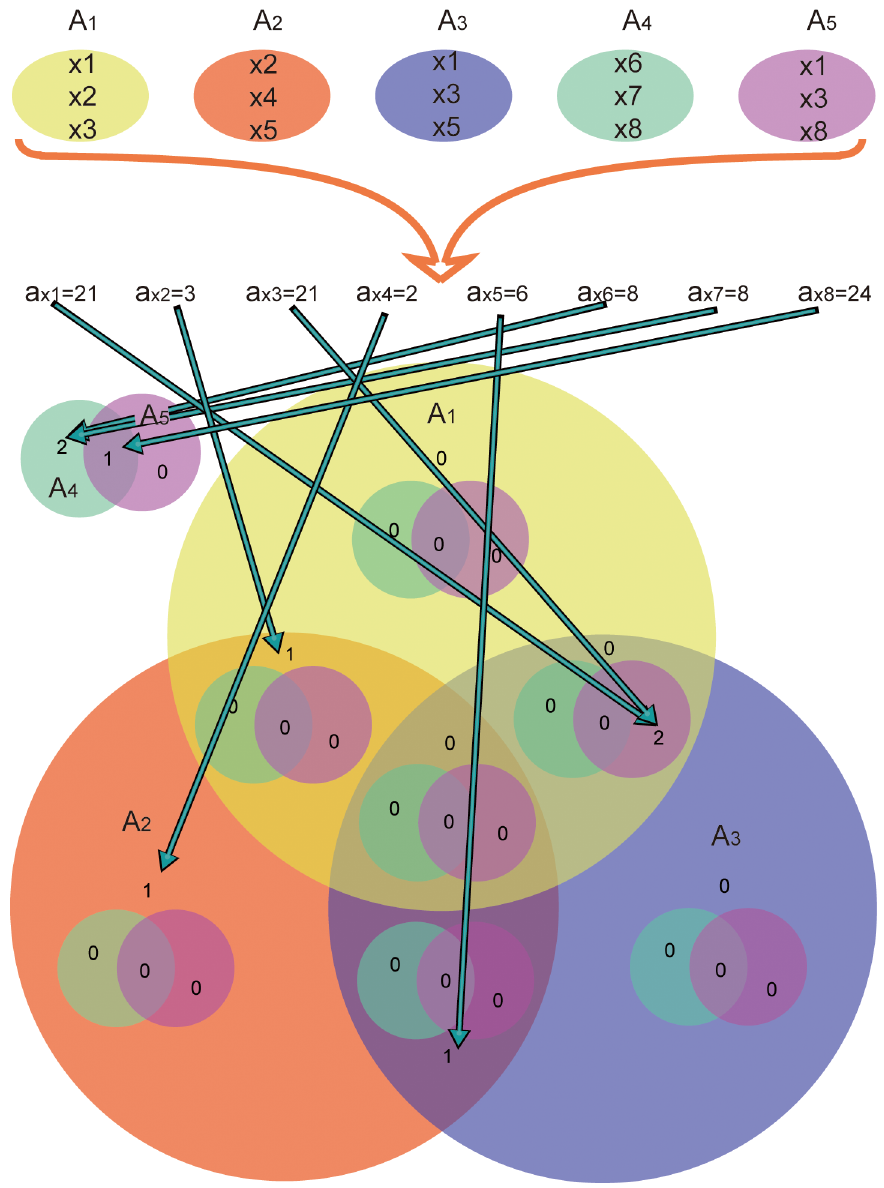
Fig 3. Work flow of VennPainter. The workflow has three steps: 1, calculate all label elements; 2, find the corresponding label in the Venn diagram; and 3, count all intersections and draw Venn